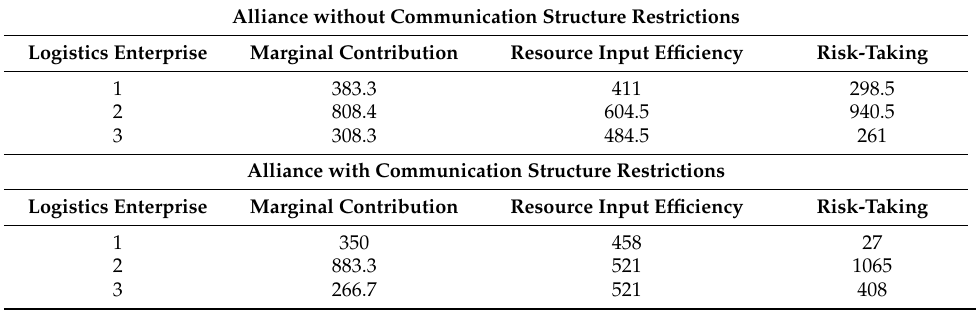
Table 5. Alliance profit distribution amount under different influencing